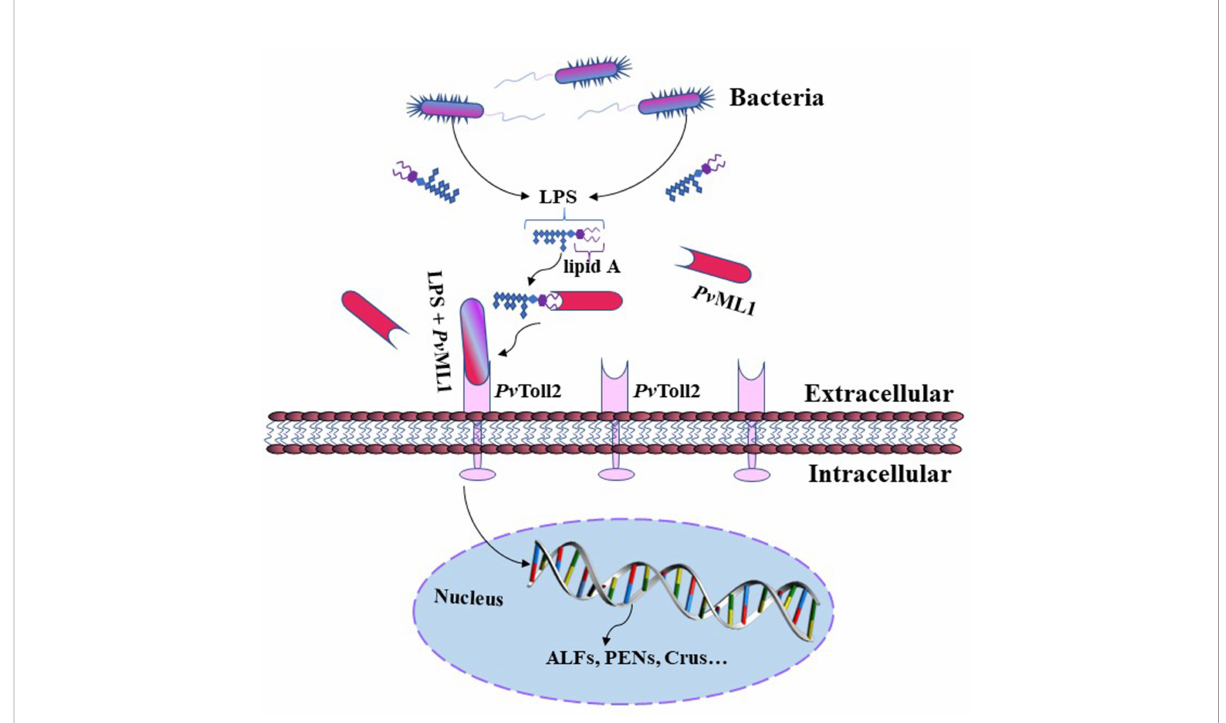
FIGURE 7 Schematic of the putative antibacterial model mediated by Pv ML1. Pv ML1 can sense bacterial invasion and bind LPS on the surface of Gram- negative bacterial cells. Pv ML1 then interacts with the extracellular region of Pv Toll2 forming a ternary complex, which may activate Pv Toll2- mediated signaling pathway and induce the expression of downstream speci fi c antimicrobial